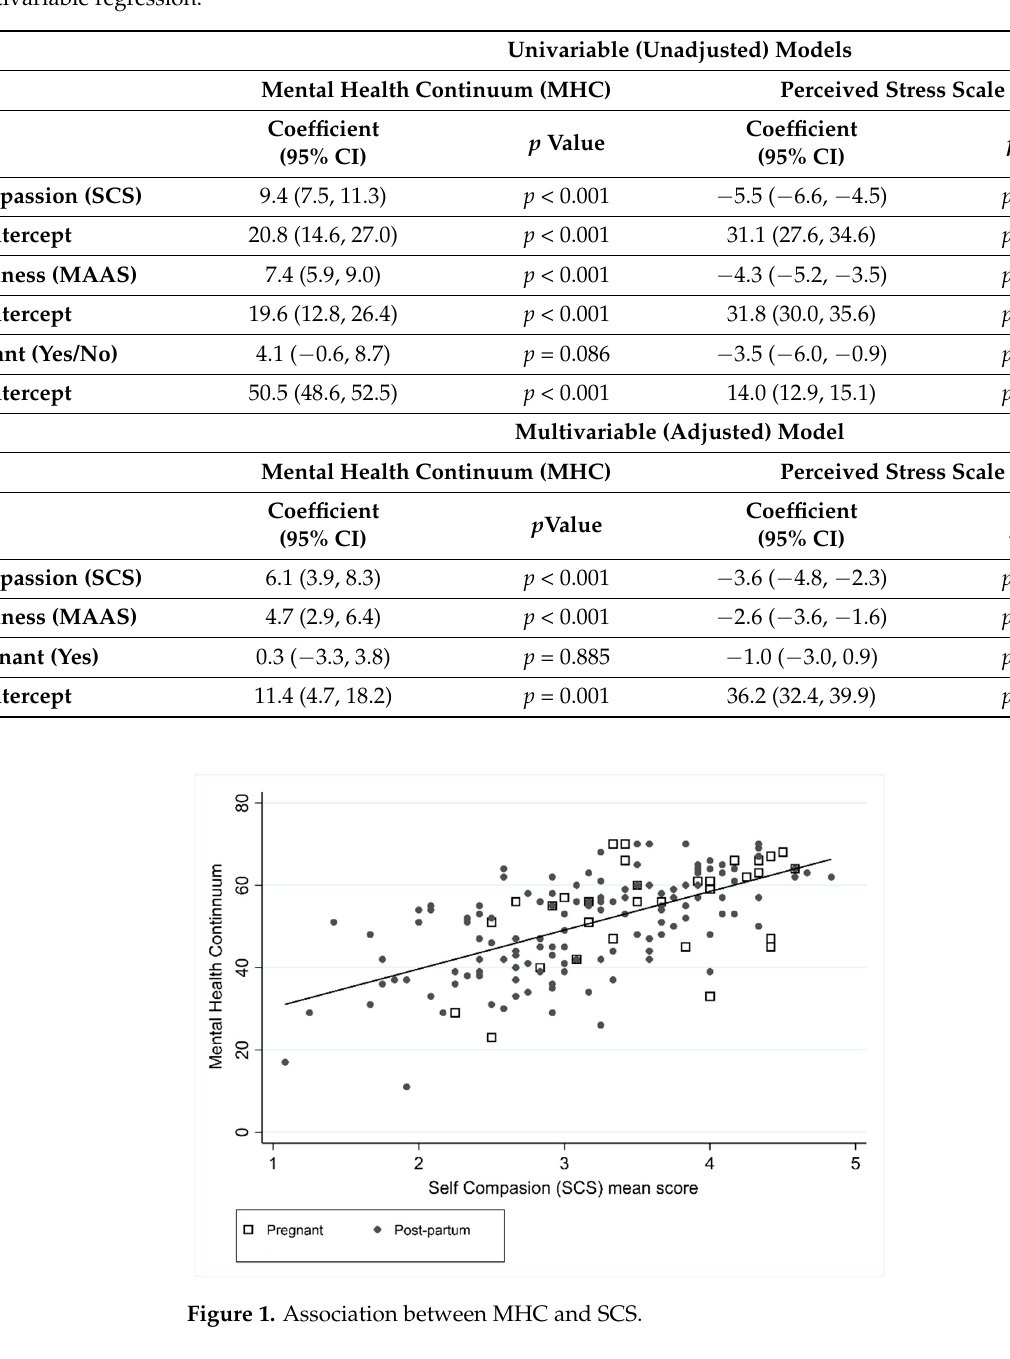
Table 2. Mental health (PSS and MHC) and its relationship with resilience (SCS and MAAS) and pregnancy using univariable and multivariable regression.